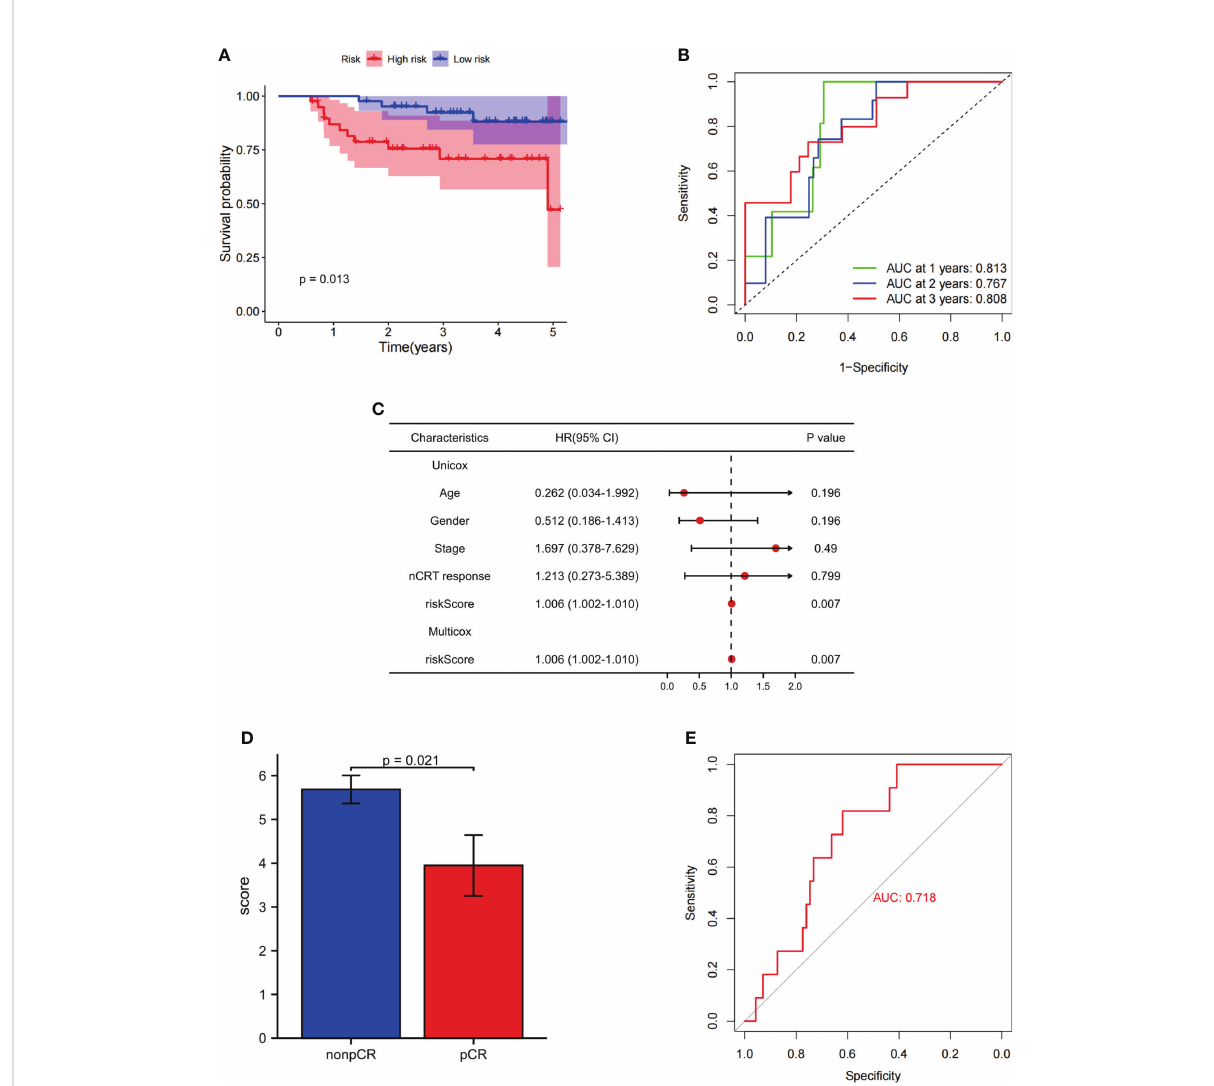
FIGURE 7 Evaluation of the ability of FAM-related signatures to predict prognosis and nCRT response in the FJCH set. (A) Kaplan – Meier survival analyses of DFS between patients with high-risk and low-risk scores in the independent cohort. (B) Time-dependent ROC curves used to evaluate the prognostic value of risk score. (C) Univariate Cox analysis and multivariate Cox analysis of clinicopathological features and FAM-related signature in DFS. (D) FAM-related risk score associated with nCRT response. (E) Evaluation of FAM-related signature to predict nCRT response. FAM, fatty acid metabolism; DFS, disease-free survival; OS, overall survival; ROC, receiver operating